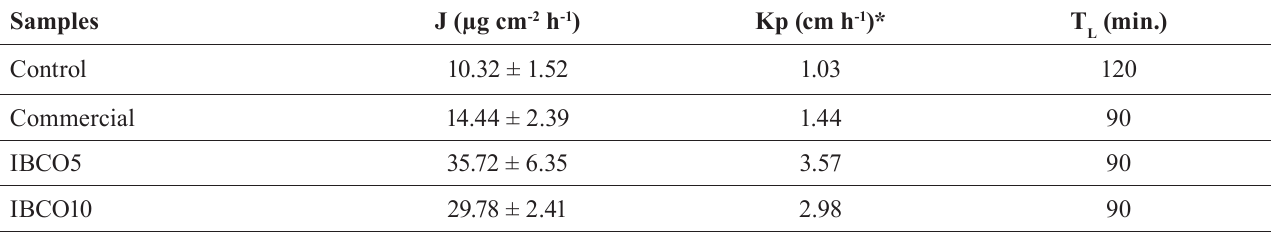
TABLE III - Steady-state flux, permeability coefficient and lag time of the samples Samples